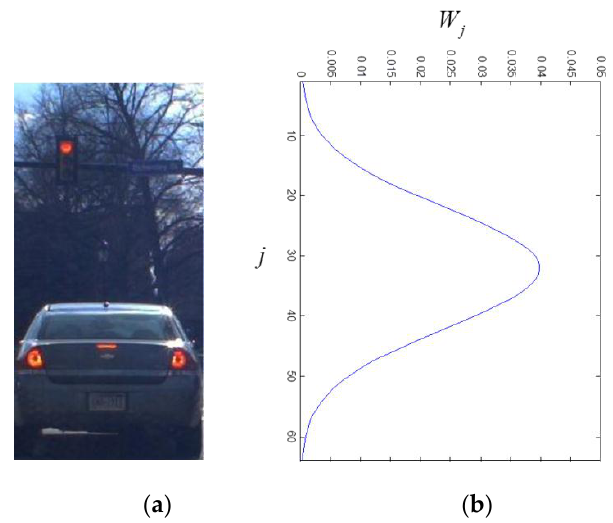
Figure 9. The prior knowledge match degree: ( a ) is the hypothesized window; and ( b ) is the prior knowledge match degree in terms of j p σ “ 10 q .